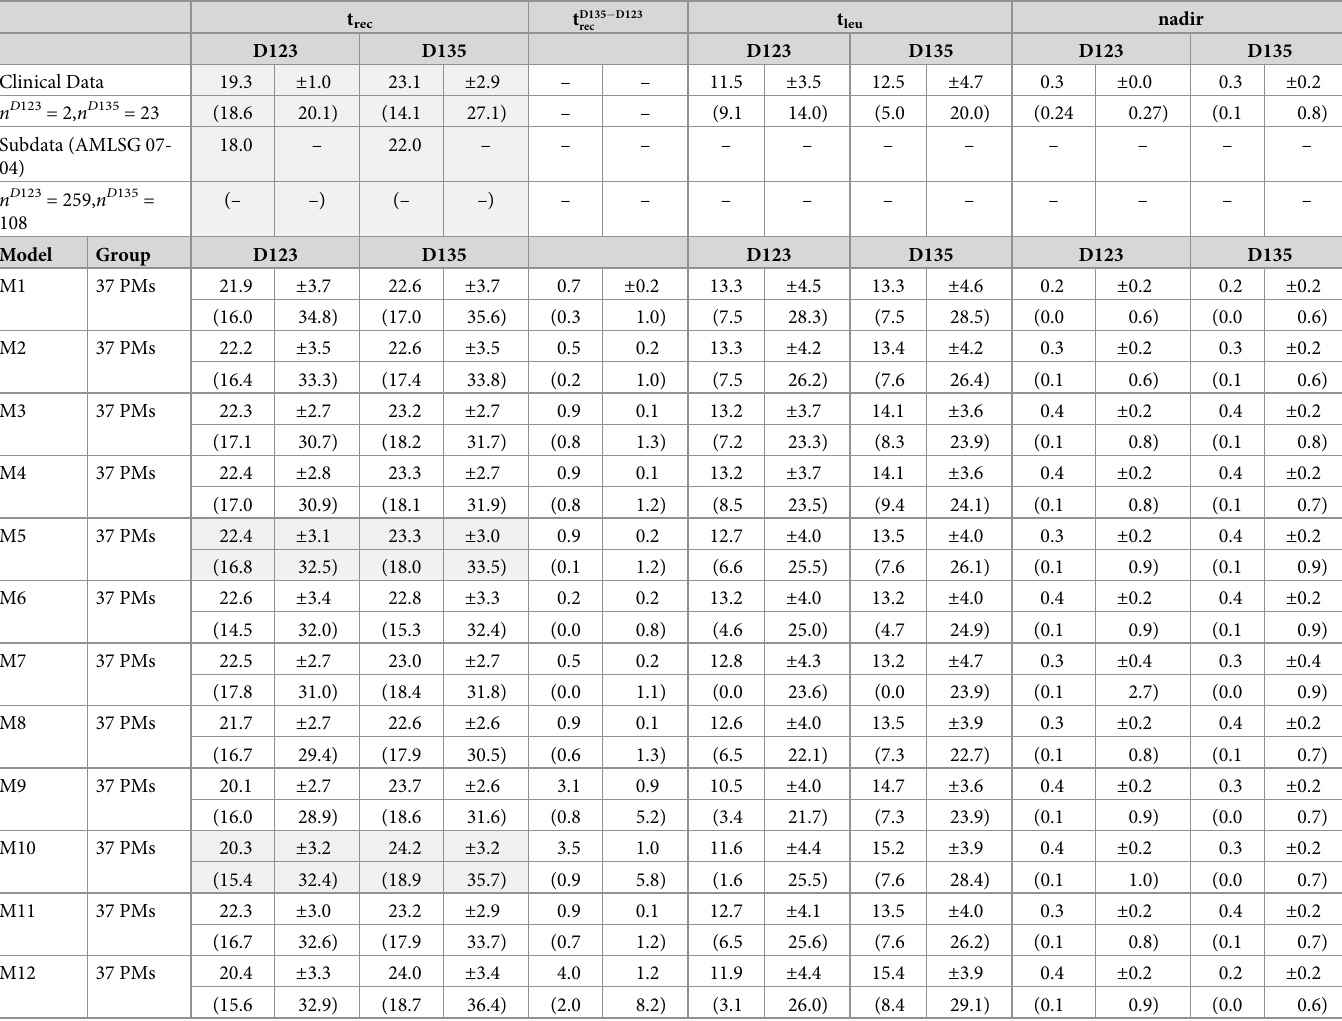
Table 4. Double cross-validation with clinical data from two independent clinical